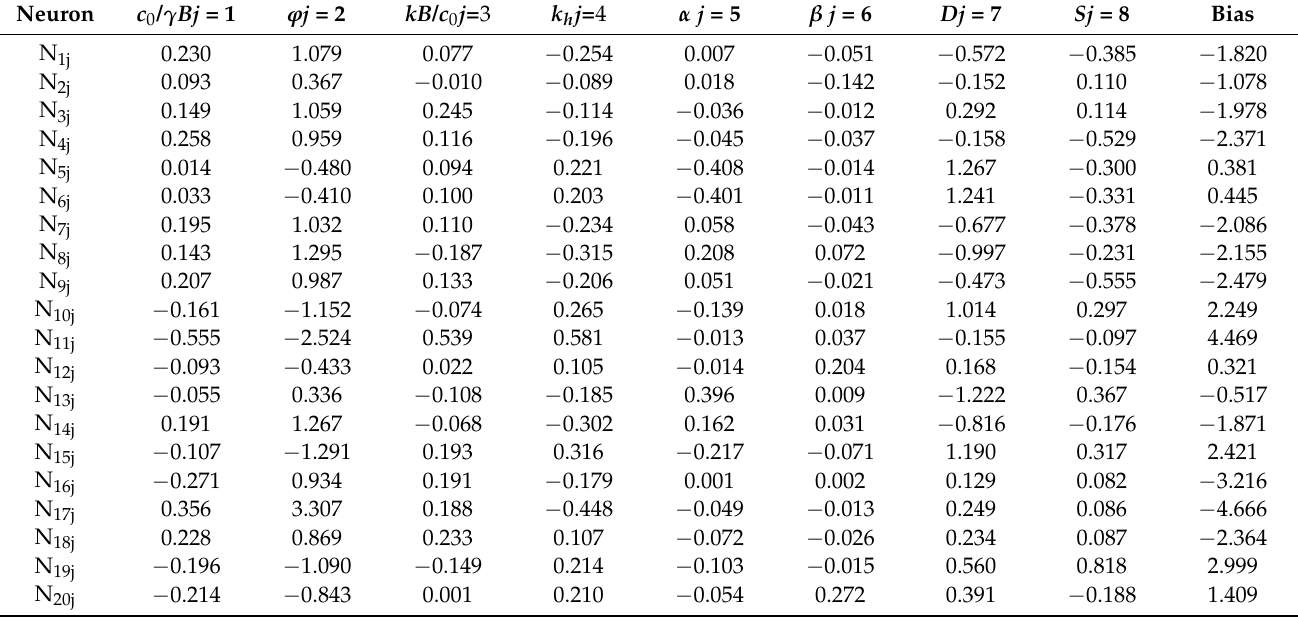
Table A1. Input-hidden weights and